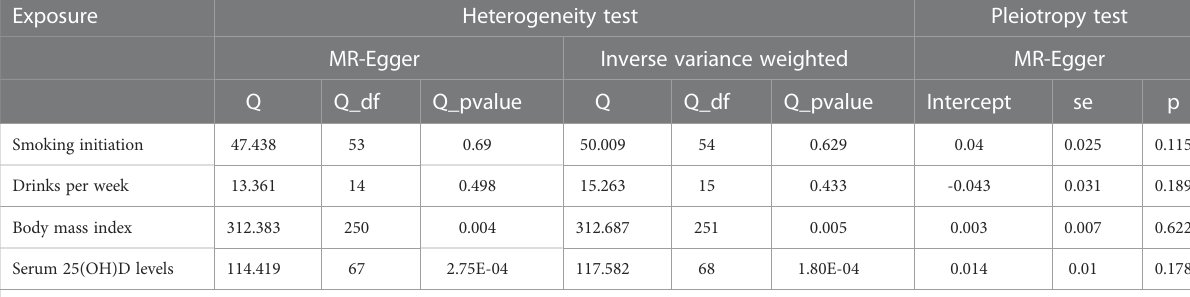
TABLE 2 Pleiotropy and heterogeneity test of the four exposures IVs from PBC GWAS.